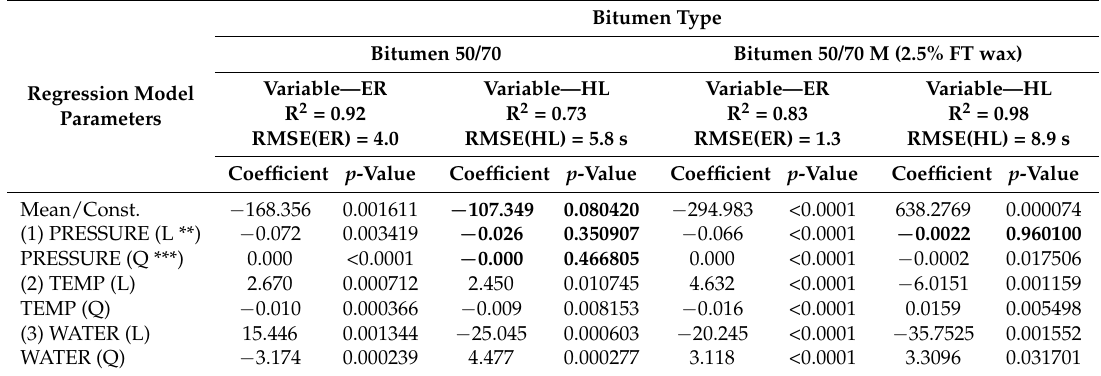
Table 5. Fitting parameters of the objective function of foam distribution parameters (ER and HL)